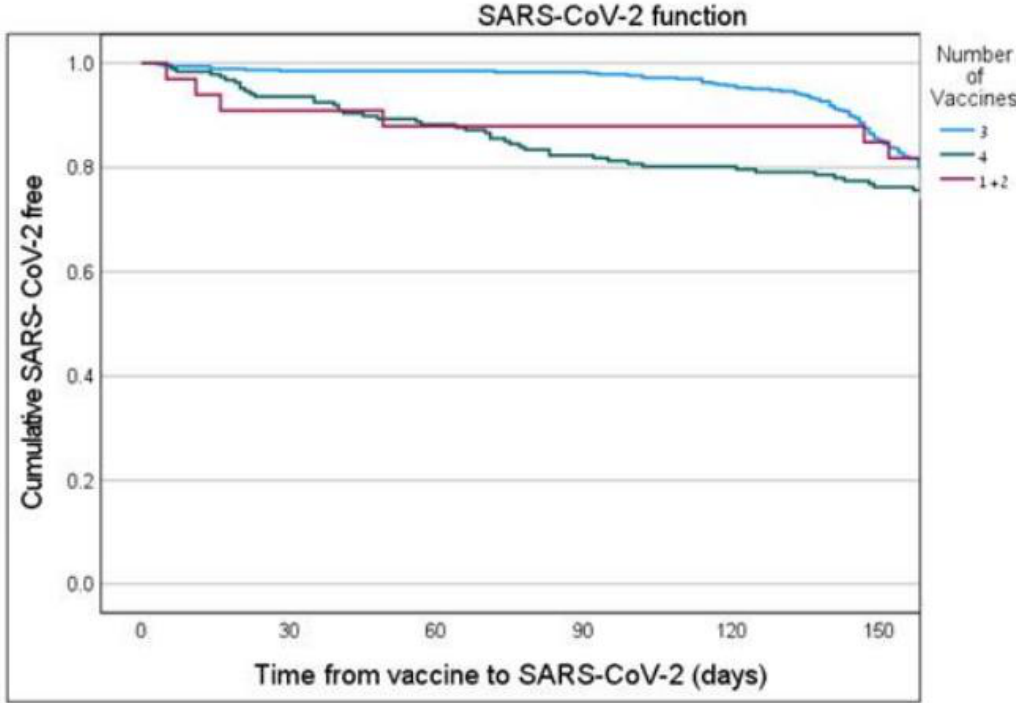
Figure 3. Disease Free Survival analysis of HCW after vaccine. p = 0.017 between 1+2 vaccine vs. 3 vaccines.